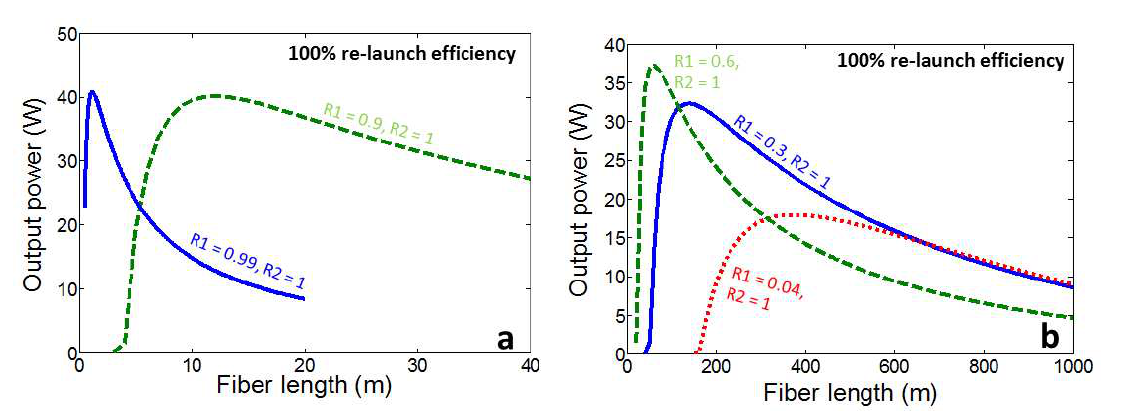
Figure 8. ( a ) Simulations of the output power vs. DCRF length at pump power of 65 W (launched) for out-coupling ratio (R1) of 0.9 and 0.99 and for 100 % re-launch efficiencies for pump as well as Stokes wave in both ends of the cavity; ( b ) Simulations of the output power vs. DCRF length at pump power of 65 W (launched) for various out-coupling ratio (R1) and 100 % re-launch efficiencies.